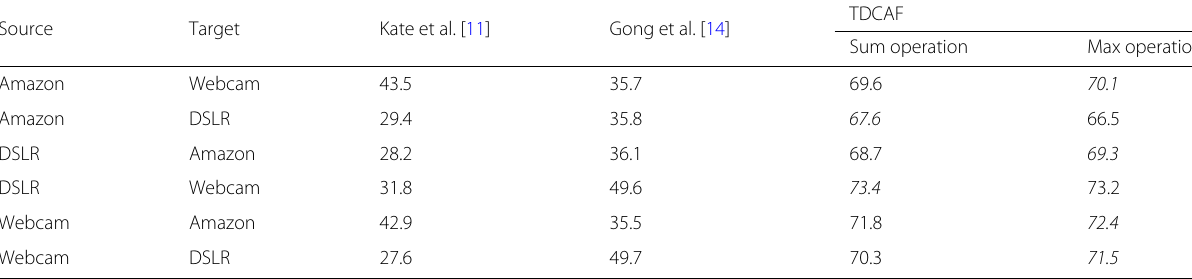
Table 2 Classification accuracies (%) for the generalized image